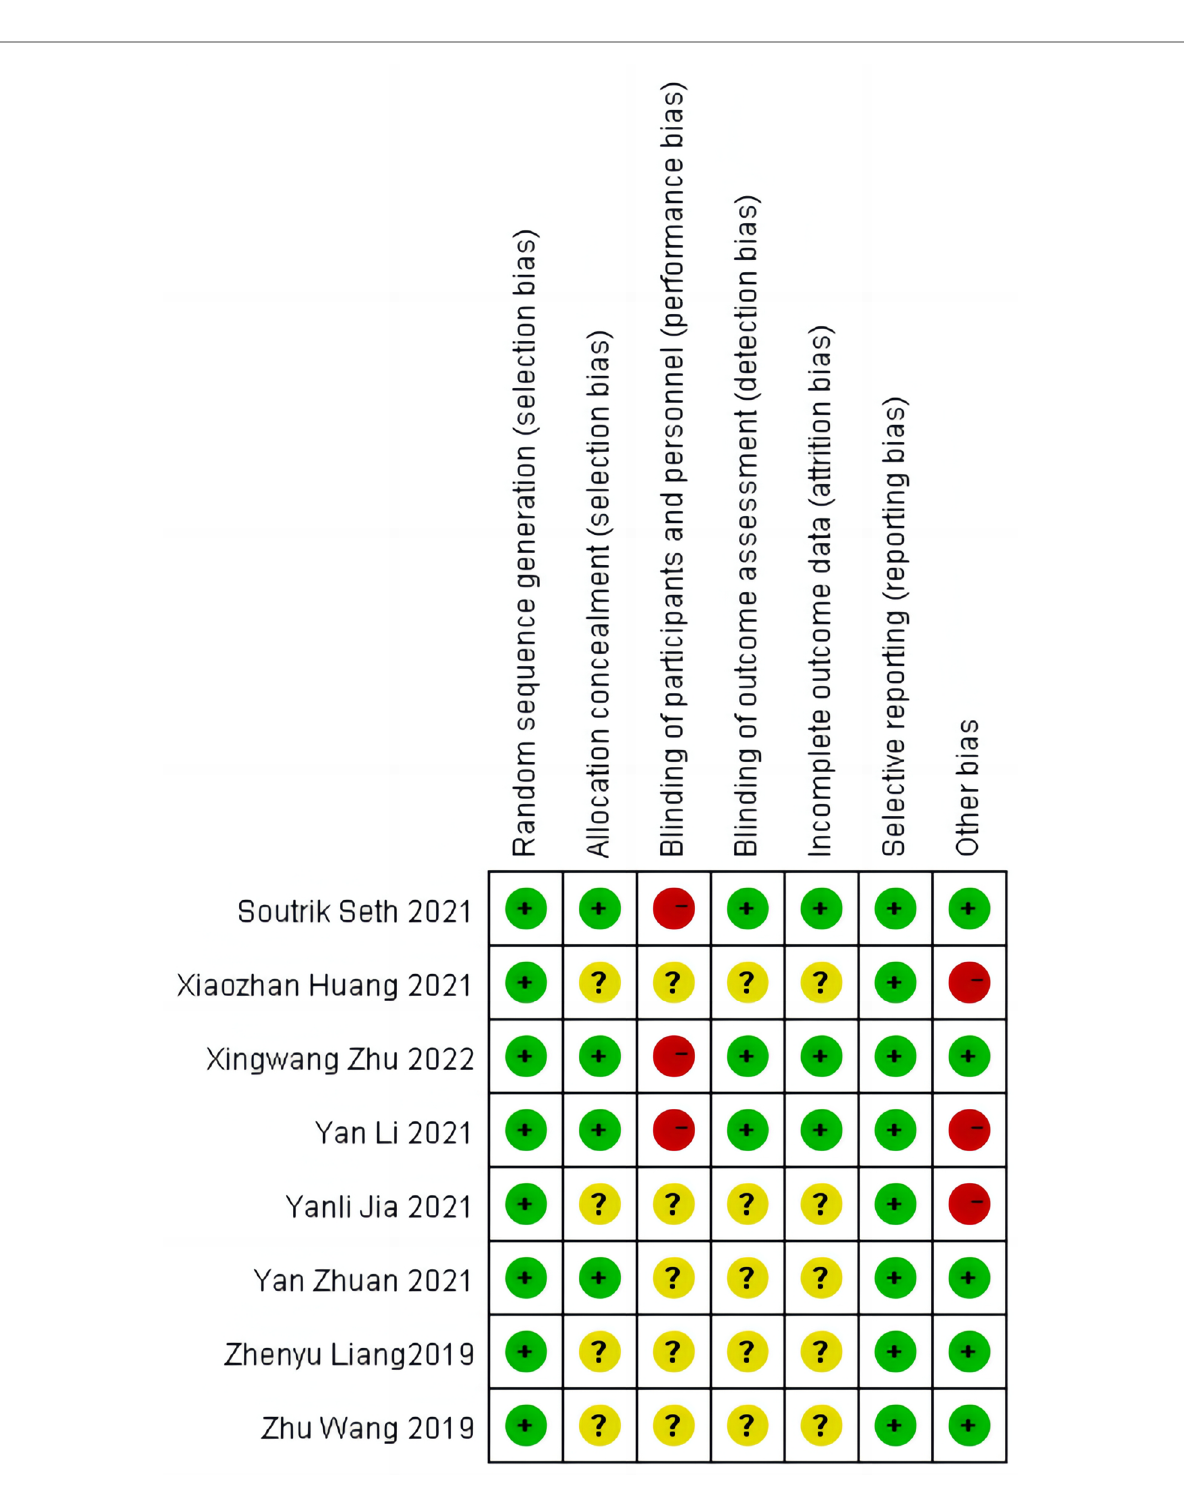
FIGURE 2 Risk of bias